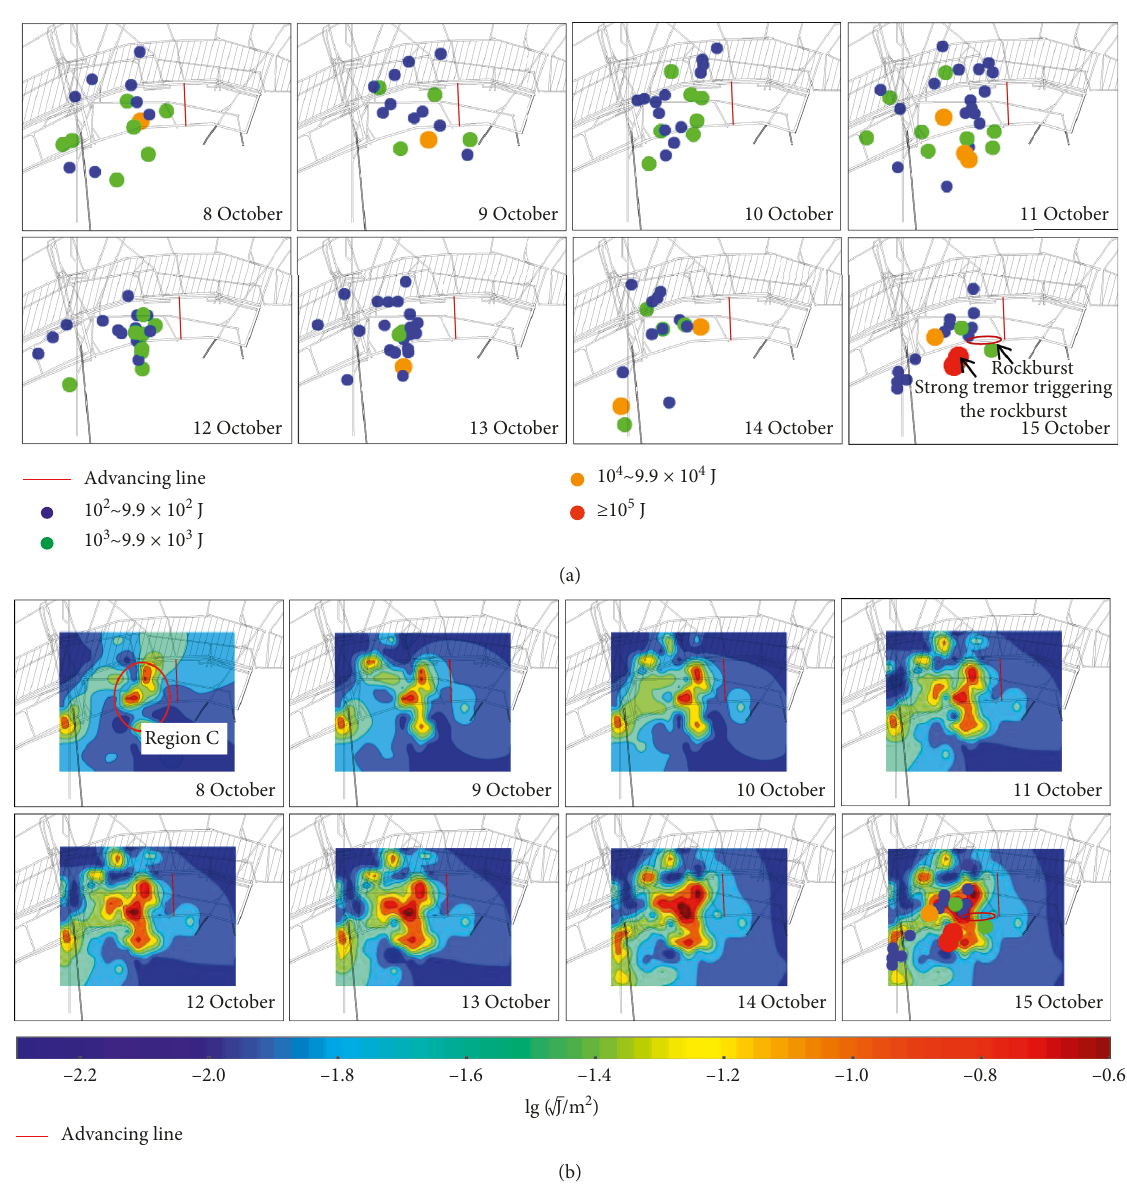
Figure 6: Evolution of spatial tremors (a) and energy density clouds (b) before a rockburst (8–15 October